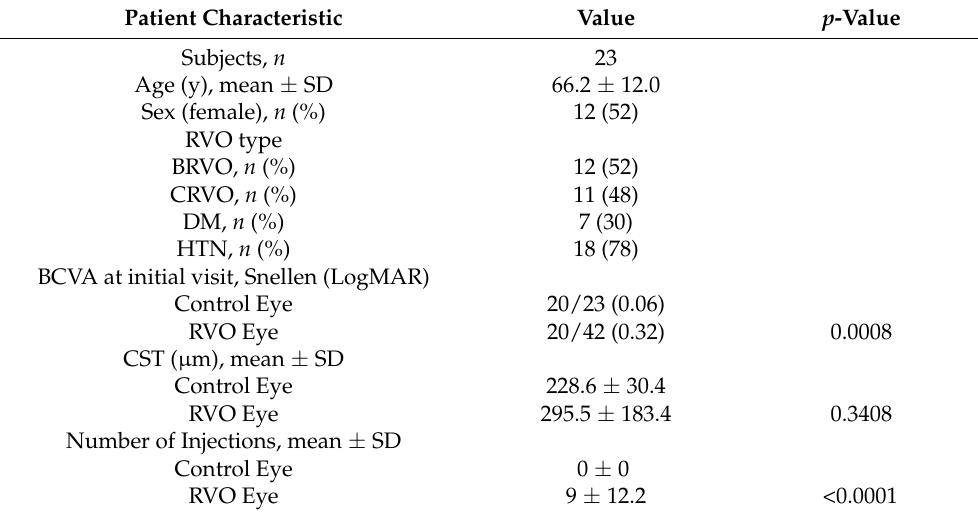
Table 1. Demographics Characteristics of